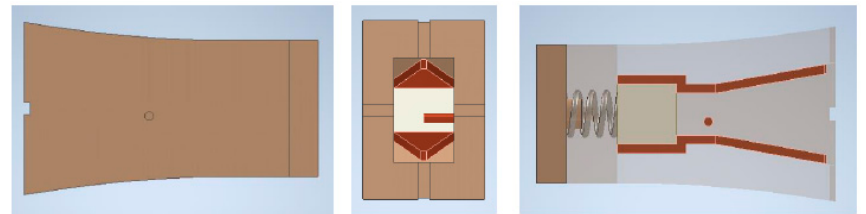
Figure 9. Final CAD of PPT.